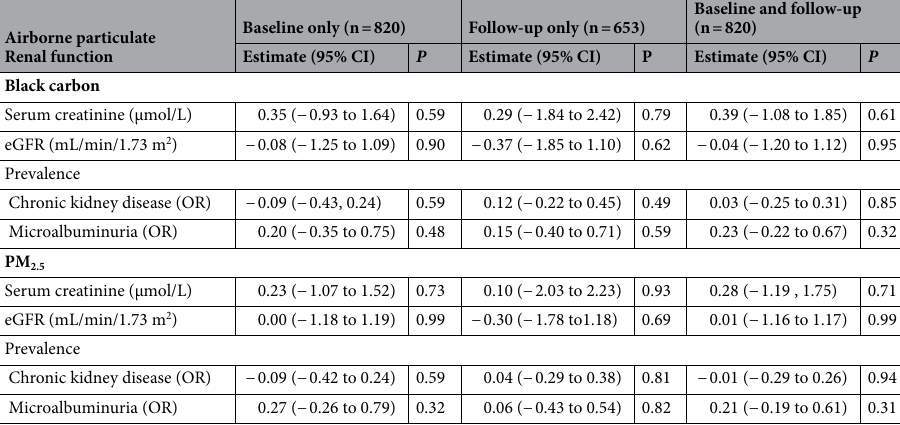
Table 3. Multivariable-adjusted cross-sectional associations of renal function with exposure to black carbon and PM 2.5 . eGFR is the glomerular filtration rate estimated from serum creatinine by the CKD-EPI formula. Associations sizes were derived from mixed models, which accounted for clustering of the baseline and follow-up data among participants living at the same address. For chronic kidney disease (eGFR < 60 mL/ min/1.73 m 2 ) and microalbuminuria (> 3.5/> 2.5 mg per mmol creatinine in women/men), association sizes are expressed as odds ratios (OR). Models were adjusted for sex, age (linear and squared term), mean arterial pressure, heart rate, body mass index, plasma glucose, total-to-HDL cholesterol ratio, γ-glutamyltransferase, smoking, daily energy expenditure in physical activity, socioeconomic class, and antihypertensive treatment (by drug class). Association sizes, given with 95% confidence interval, were expressed for an interquartile range increment in the airborne